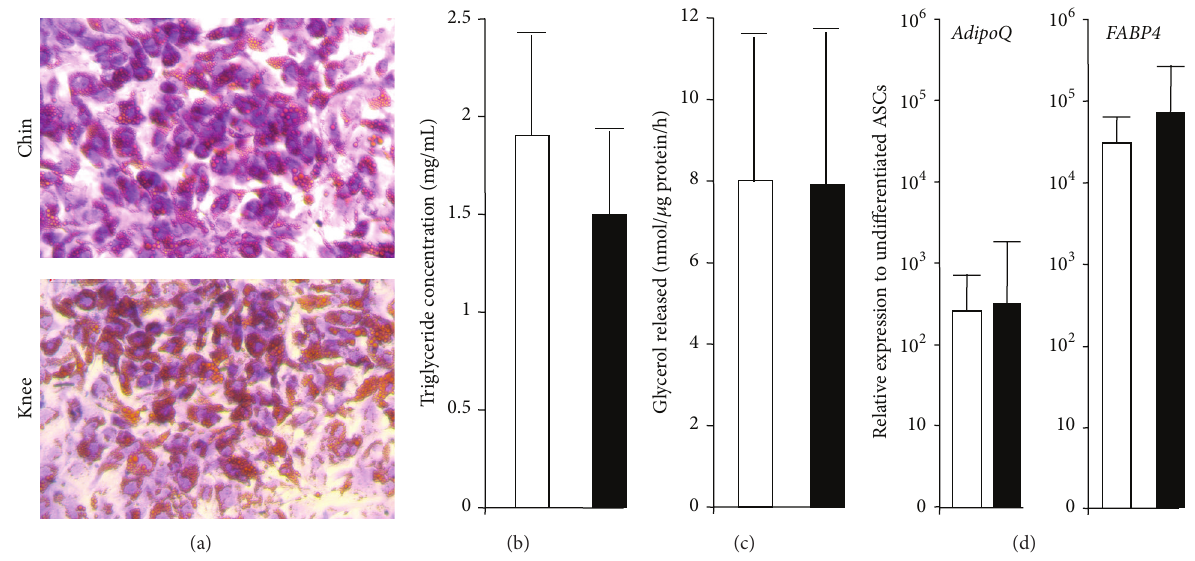
Figure 4: Adipocyte differentiation of chin- and knee-ASCs. ASCs were induced to undergo differentiation for 10 days. (a) Cells were stained with Oil Red O for lipid droplets. (b) Cells were harvested and analyzed for their triglyceride content. (c) Cells were stimulated with forskolin for 4h and then glycerol release was determined. (d) RNAs were prepared and differentiation levels were assessed by the expression of the indicated genes. Expression of each gene was normalized to TBP and then relative to the expression in undifferentiated cells. Values are means ± SEM. 𝑃 is indicated ( 𝑛 = 7 paired depots). Open bars: chin; black bars: knee.